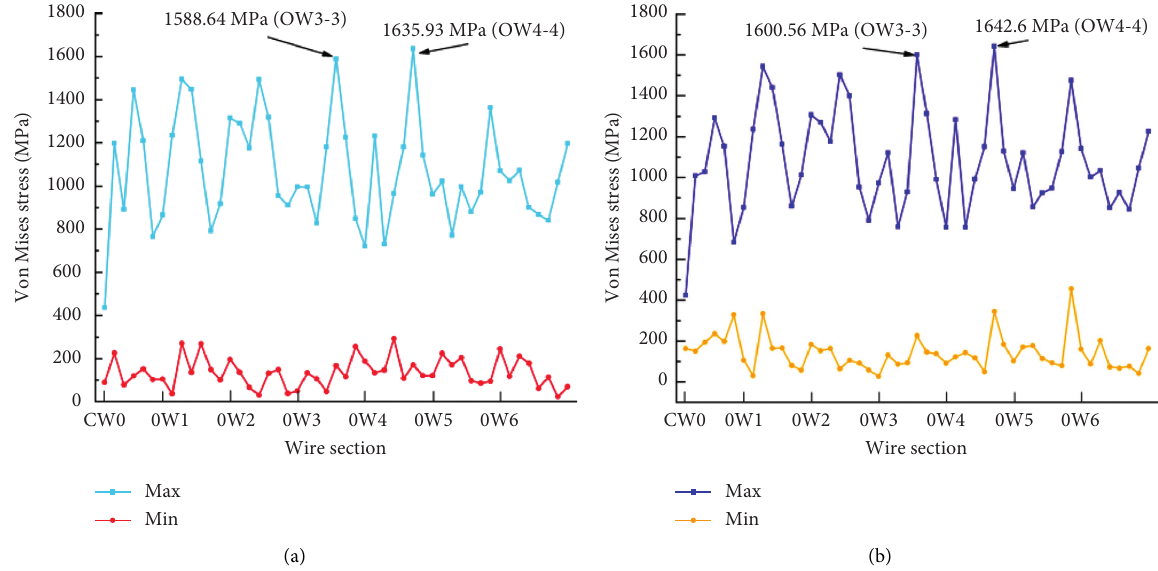
Figure 16: Von Mises Stress of each section of continuous and discontinuous rope. (a) Von Mises Stress of continuous rope section. (b) Von Mises Stress of discontinuous rope section.